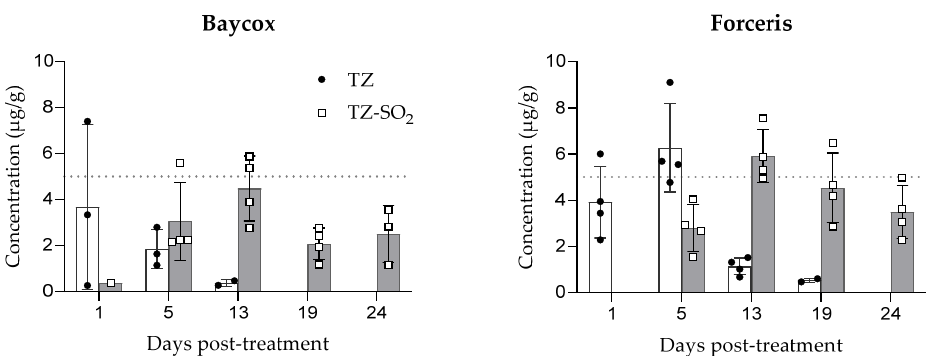
Figure 3. Concentrations of toltrazuril and toltrazuril sulfone (mean ± SD) in the ileum following single oral (Baycox 5%) or intramuscular (Forceris) administration to piglets.